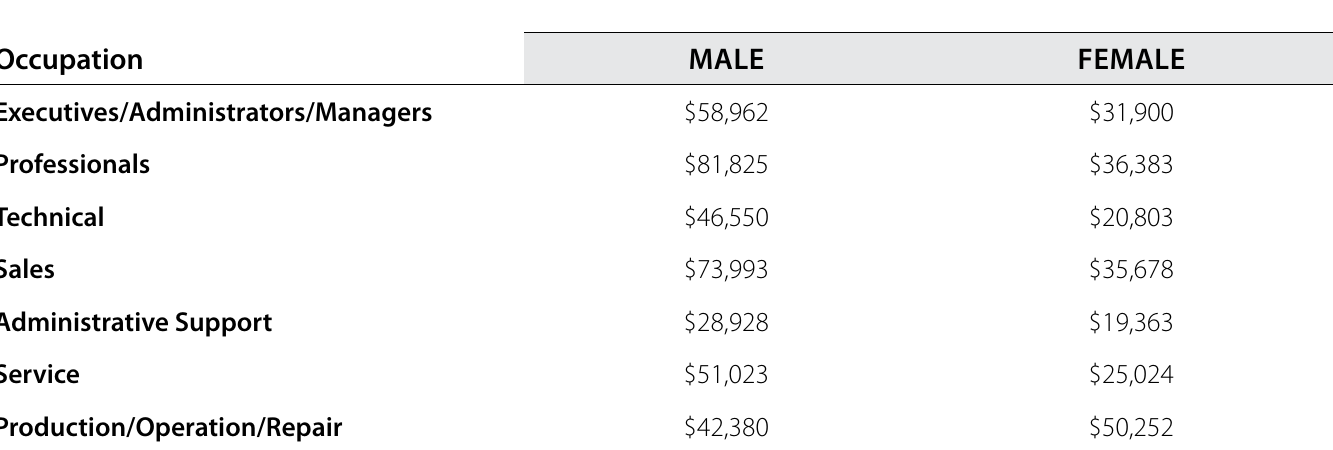
Table 5b. GLM Analysis of Earning Differences by Gender and